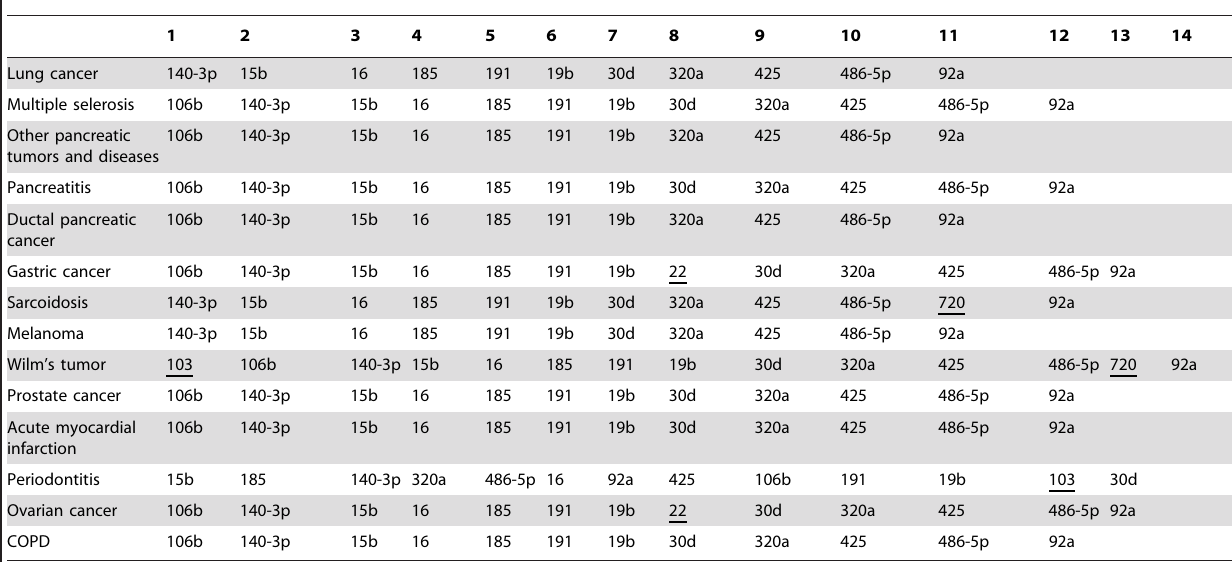
Table 6. miRNAs used for discrimination between